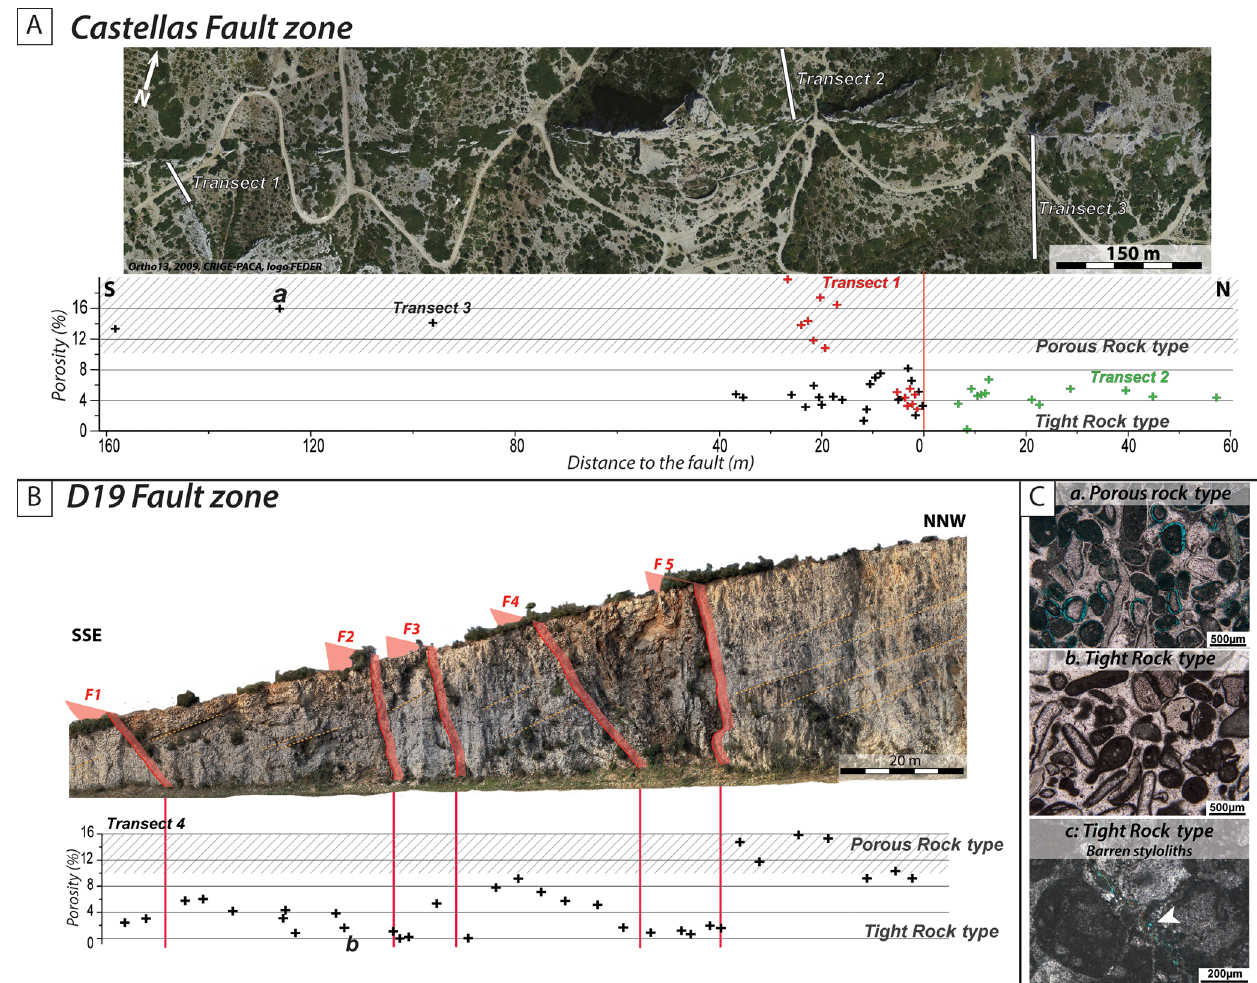
Figure 3. (A) Castellas Fault zone aerial view (Ortho13, 2009, CRIGE-PACA, logo FEDER) and porosity values measured along transect 1 (red cross), transect 2 (green cross), and transect 3 (black cross); (B) porosity values measured along D19 Fault zone; (C) Pore types in the host rock (a) and in the fault zones ( b and c